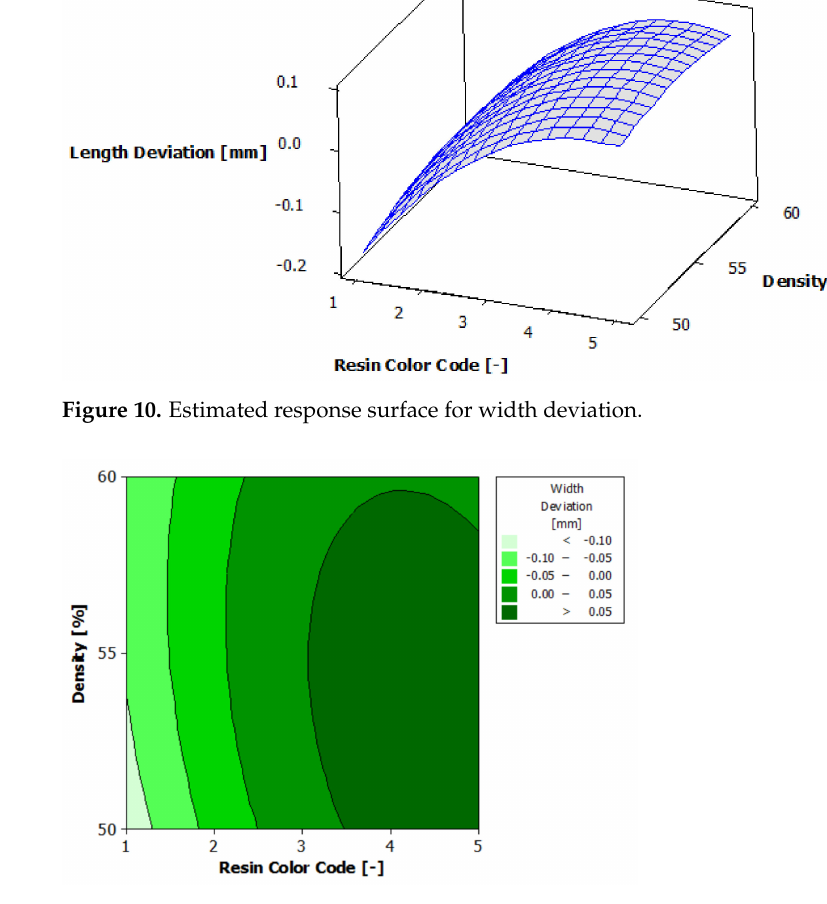
Figure 11. Contours of estimated response surface for width deviation.